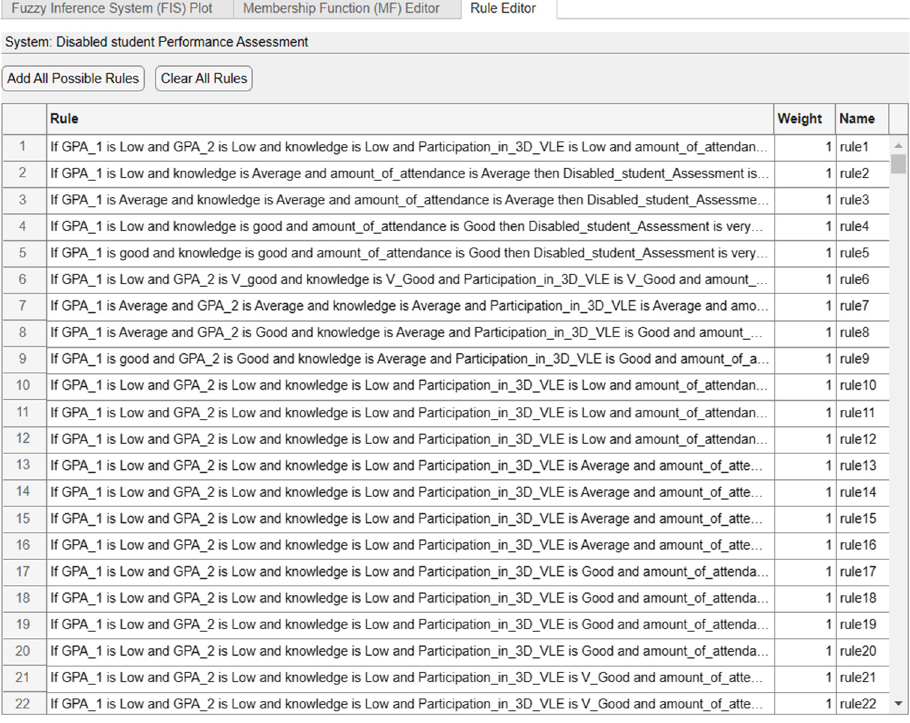
Table 7. The Disabled Student’s Performance Scores.